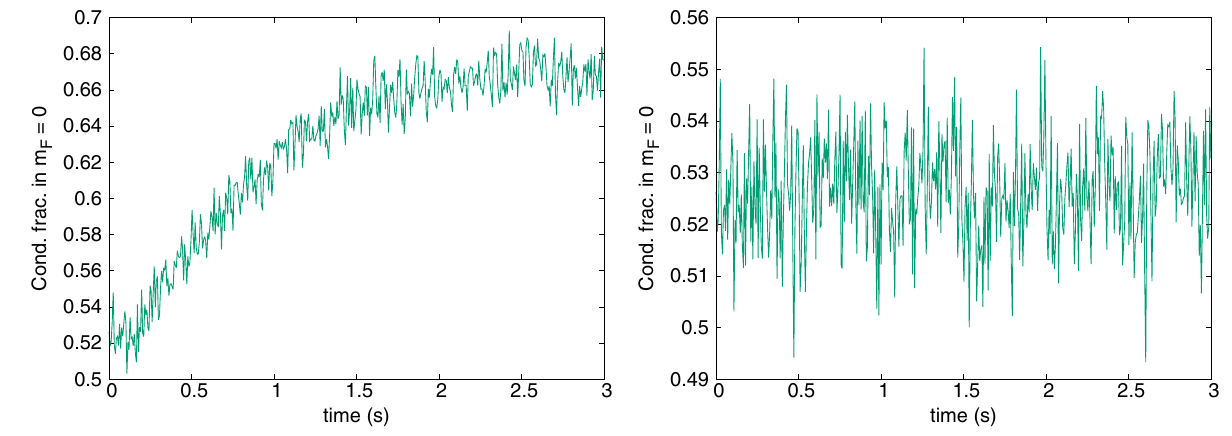
0 component as a function of time at magnetic fields of = 392 mG (right, q 0.17 (cid:31) ω x ). = =